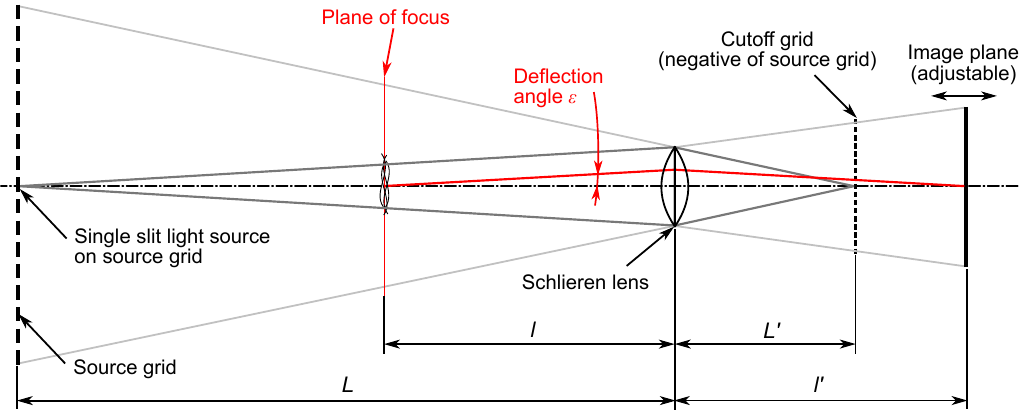
Figure 1. Schematic illustration of the focusing effect of a focusing schlieren system using the example of a single source point (adapted from Weinstein